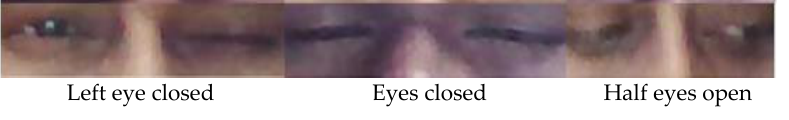
illumination and occlusion conditions as shown in Figure 5.